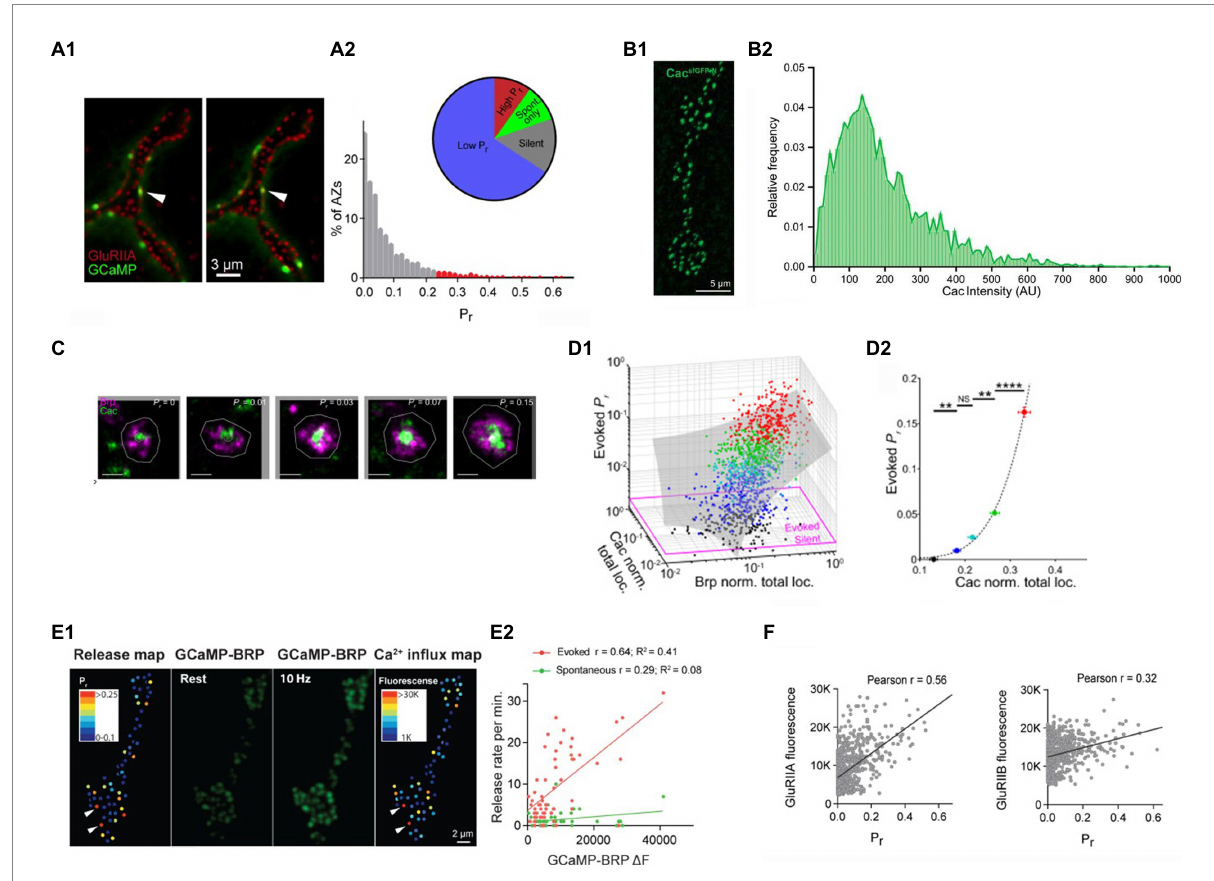
FIGURE 2 The probabilities of evoked release at individual AZs are largely determined by the clusters of Cac channels. (A) The distribution of the probabilities of evoked release p r is highly skewed. (A1) Double labeling for GCaMP events (green) and postsynaptic glutamate receptors (red). (A2) The distribution of p r shows a small proportion of AZs (high p r ) having the release probabilities exceeding the mode of the distribution by over twenty- fold. Adopted from Akbergenova et al. (2018). (B) The distribution of Cac abundance across individual AZs. (A1) The visualization of GFP-tagged Cac clusters. (A2) The distribution of Cac intensity has a noticeable skew. Adopted from Gratz et al. (2019). (C) STORM images of Cac clusters at AZ centers (green) surrounded by Brp (red). AZs with higher p r have larger Cac clusters. Adopted from Newman et al. (2022). (D) The probability of evoked release p r is positively correlated with Cac abundance (D1) p r is positively correlated with the size of Brp and Cac clusters. (D2) p r dependence on Cac is super-linear (right). The data points are color-coded according to their p r values. Adopted from Newman et al. (2022). (E) The probability of evoked release p r is positively correlated with Ca 2+ influx. (E1) The p r map and the Ca 2+ influx map derived from the increase in GCaMP-Brp fluorescence monitored at a 10 Hz stimulation frequency. (E2) p r , unlike the frequency of spontaneous transmission, is positively correlated with the presynaptic Ca 2+ signal. Adopted from Akbergenova et al. (2018). (F) The probability of evoked release p r shows a strong positive correlation with the abundance of GluRIIA but not GluRIIB postsynaptic glutamate receptors. Adopted from Akbergenova et al.